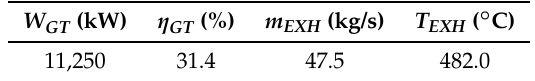
Table 2. GE10 single shaft gas turbine main specification [20].